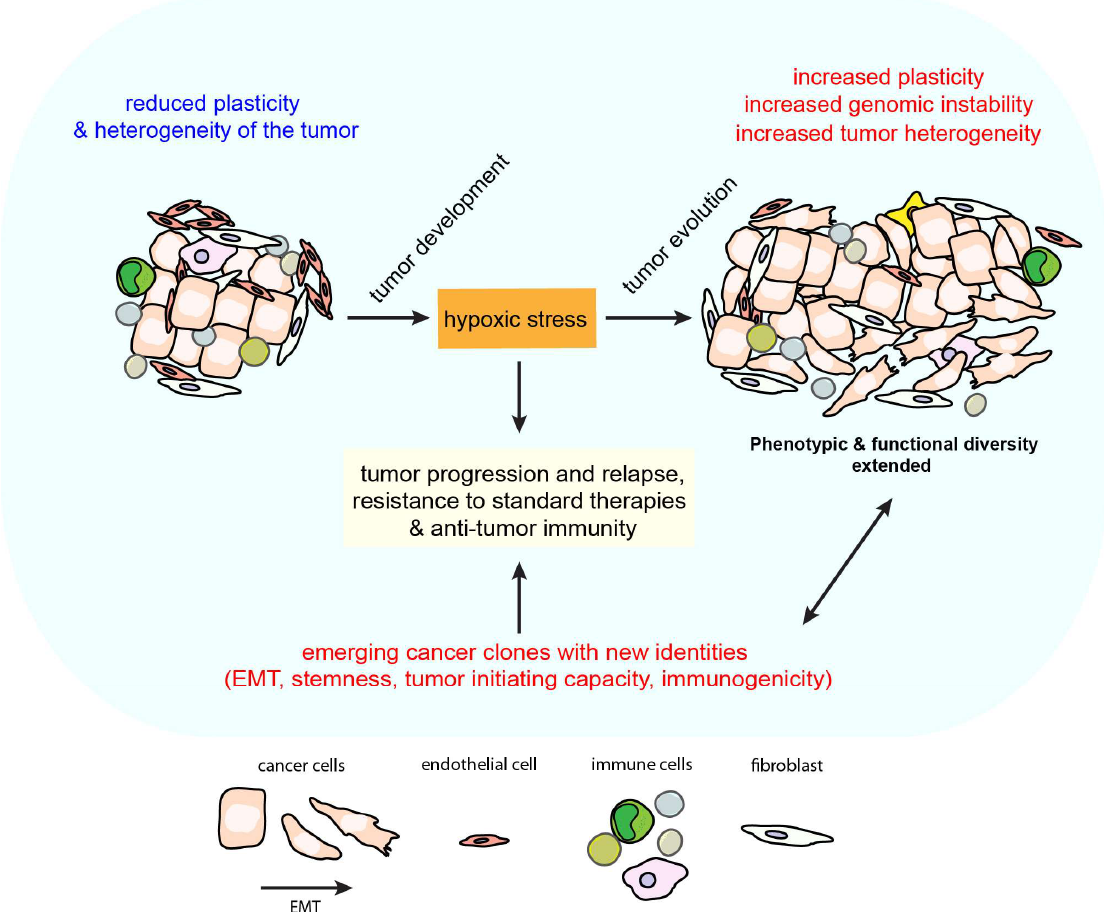
Figure 1. Tumors contain distinct cell types that collectively enable tumor growth and progression. Hypoxic stress can contribute by increasing cell plasticity, genomic instability and phenotypic heterogeneity of certain carcinoma cells, leading to intra-tumor heterogeneity and the emergence of cancer clones resistant to therapies and anti-tumor immunity.